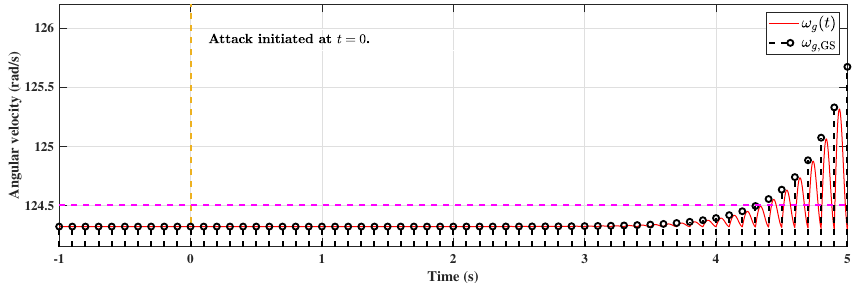
Figure 10. ZDA detection using a generalized sampler (GS).